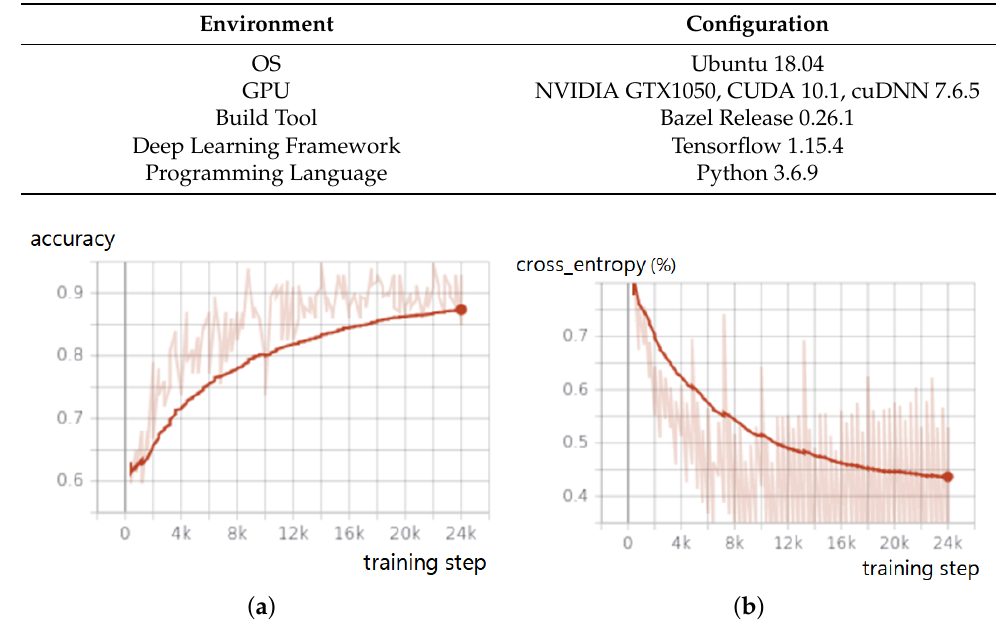
Figure 2. Training accuracy and loss: ( a ) Accuracy. ( b ) Loss measured in cross entropy.